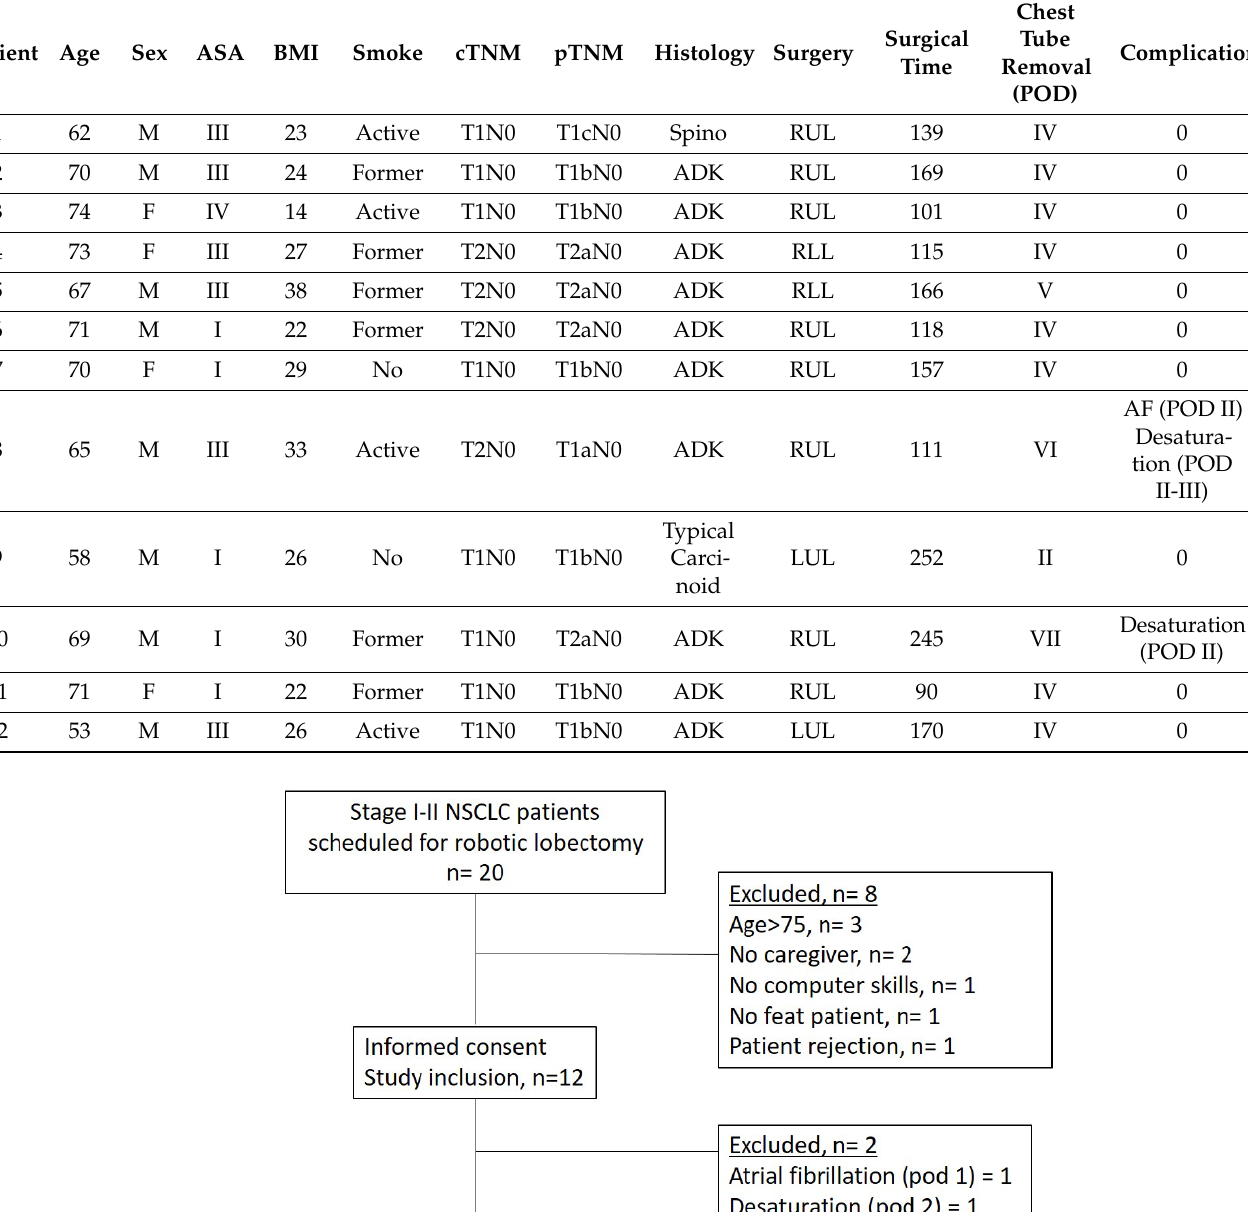
Table 1. Patients’ clinical and pathological features.